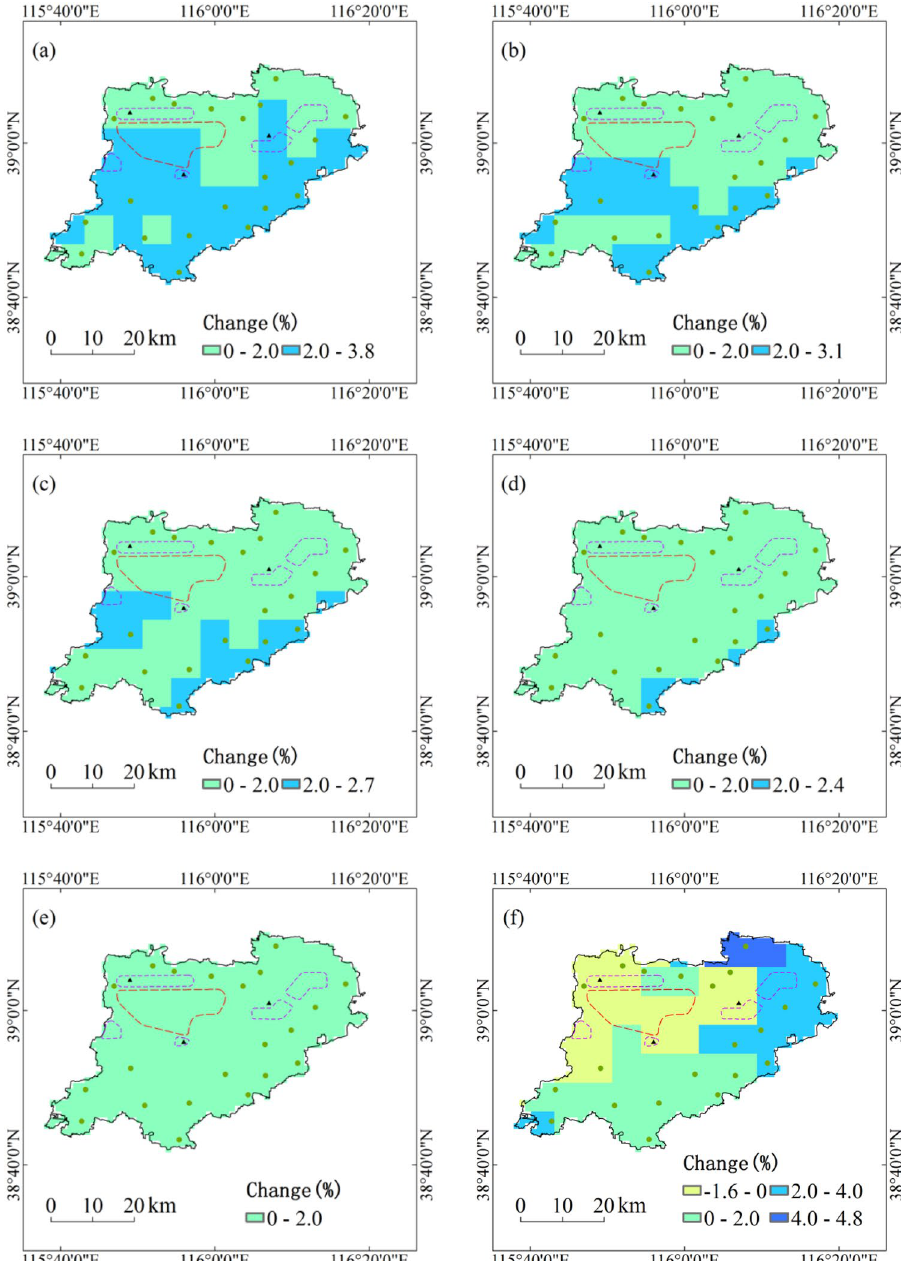
Figure 3. Projected changes of annual maximum amount of consecutive precipitation with five return periods during the period 1991–2050. Maps show return periods of 10-year ( a ), 20-year ( b ), 30-year ( c ), 50-year ( d ) and 100-year ( e ) under RCP4.5 scenario and return periods of 10-year ( f ), 20-year ( g ), 30-year ( h ), 50-year ( i ) and 100-year ( j ) under RCP8.5 scenario. Maps generated in ArcGIS